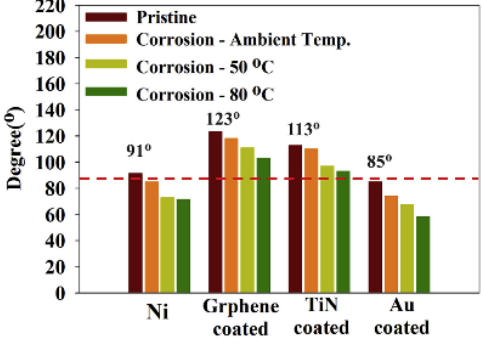
Figure 13. Substrates water contact angle [93].